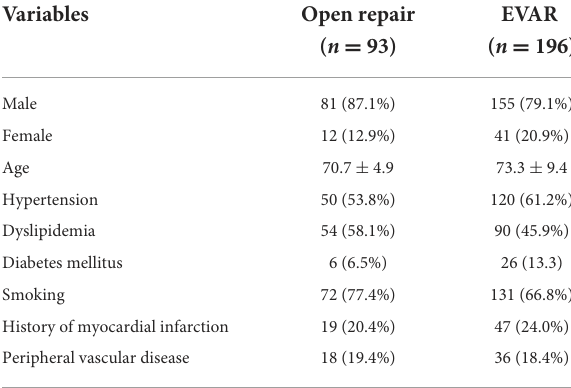
TABLE 3 Demographics and comorbidities of patients undergoing open repair or EVAR for AAA during 2004–2019 in elder